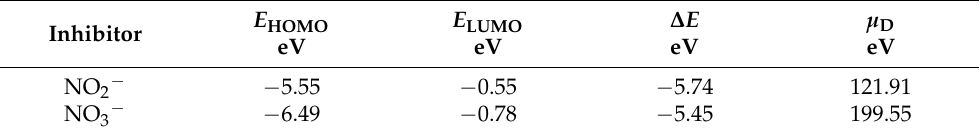
Table 6. Quantum chemical parameters for NO 2 − and NO 3 − in aqueous phase calculated using DFT/B3LYP/6-31G (d,